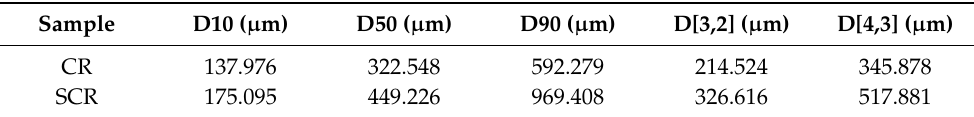
Figure 11. Particle size distribution curve of CR and SCR. Table 6. Statistics of average particle size for CR and